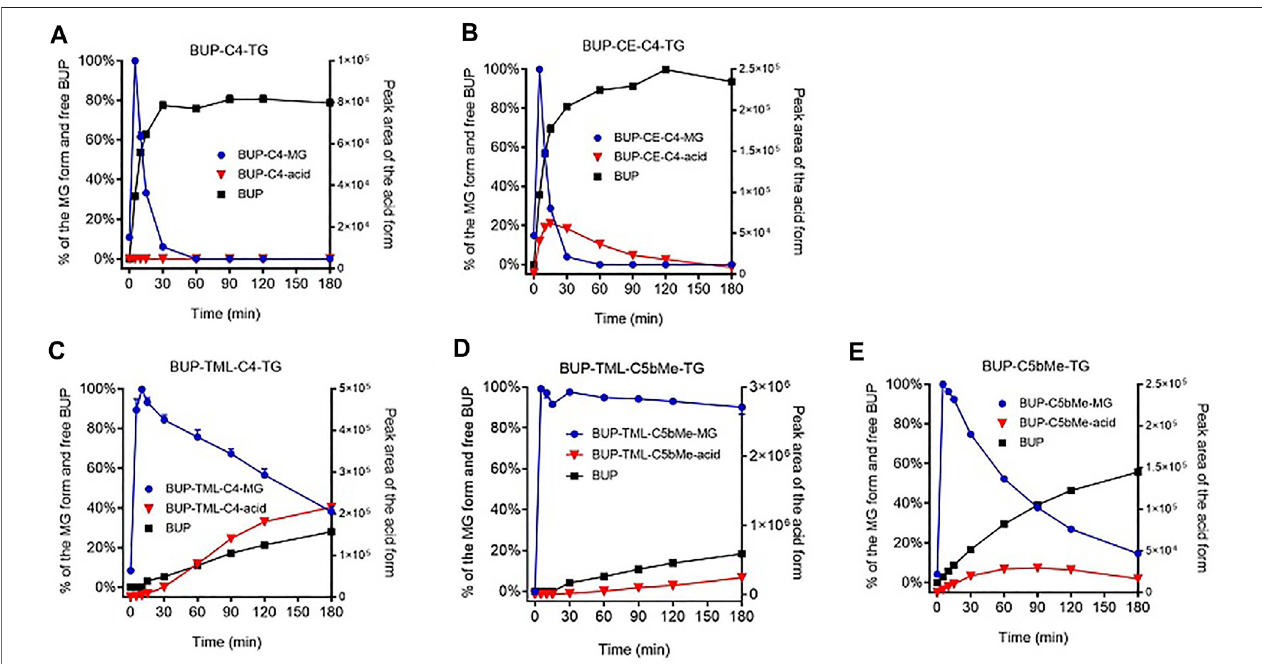
FIGURE 3 | GI stability pro fi les of BUP prodrugs. Data are shown as % mass change (Mean ± SEM, n = 3) for MG-like forms and parent BUP, or as arbitrary peak area for BUP-linker acid forms, upon in vitro incubation of BUP-C4-TG (A) , BUP-CE-C4-TG-TG (B) , BUP-TML-C4-TG (C) , BUP-TML-C5bMe-TG (D) , and BUP- C5bMe-TG (E) , with simulated intestinal fl uid (SIF) containing porcine